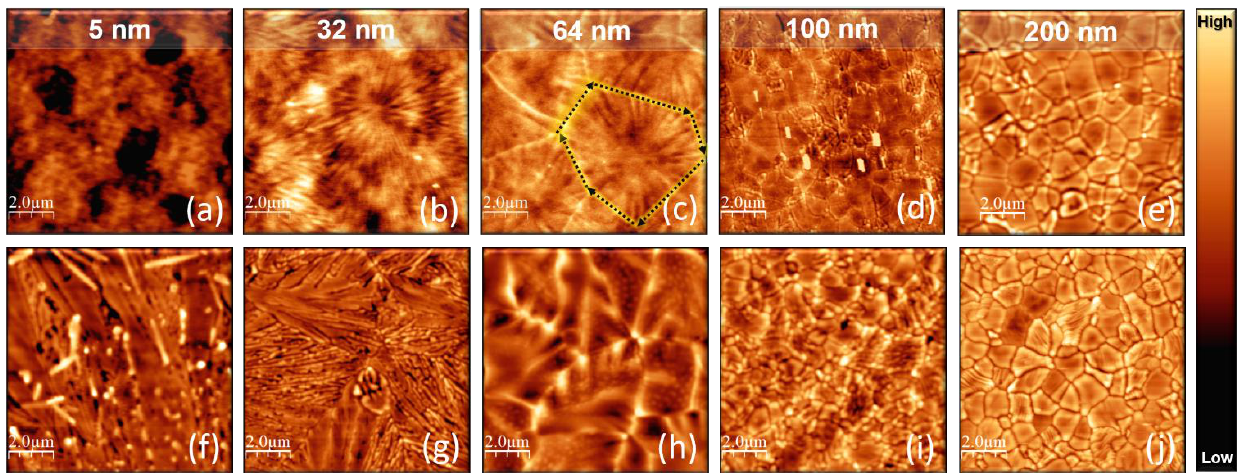
Figure 6. Tapping mode AFM topography, 10 × 10 μm in size, of: ( a ) 5, ( b ) 32, ( c ) 64, ( d ) 100, and ( e ) 200 nm samples, annealed at 800 °C. In figure ( c ), the black dotted arrows are guides for the eye highlighting grain boundaries. ( f ) 5, ( g ) 32,